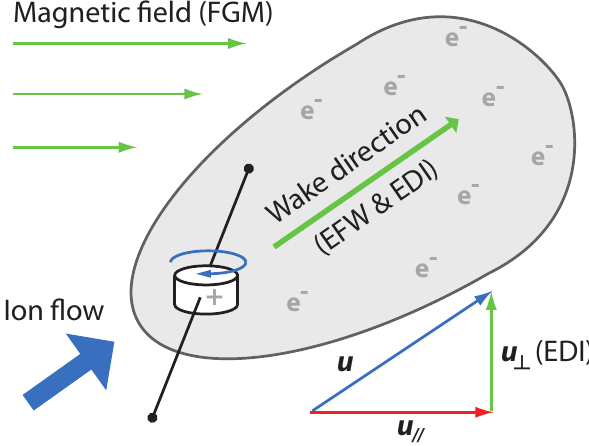
Fig. 2. Method to derive ion flow velocity on Cluster. The flow ve- locity can be derived from the negative wake created behind a posi- tively charged spacecraft with knowledge of three quantities (shown in green): (1) the direction of the wake, (2) the ambient magnetic field, B , and (3) the velocity perpendicular to B . The direction of the wake, which is in the flow direction, is given by the wake elec- tric field E w = E EFW − E EDI . The EFW double probes separated by 88m wire booms will be affected by the wake field, whereas the EDI electron beam will not. The magnetic field is obtained from the FGM instrument on-board Cluster and the perpendicular veloc- ity is inferred from EDI: u ⊥ = E EDI × B /B 2 . Equation (4) is used to derive the parallel velocity, u k , and the total ion flow velocity, u , is thus also obtained. (The sketch shows the simplified case, when the magnetic field and the wake is in the spacecraft spin